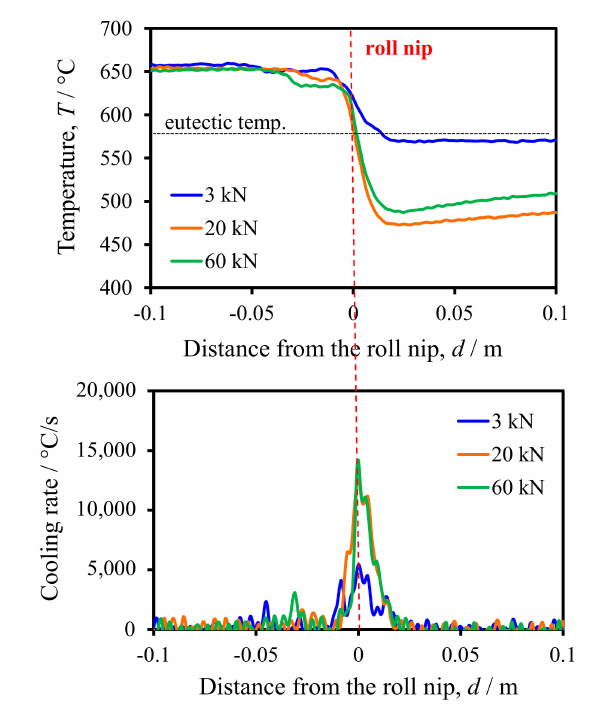
Figure 2. Changes in the ( a ) temperature and ( b ) cooling rate in the mid-thickness region of the strips under various roll separating forces.